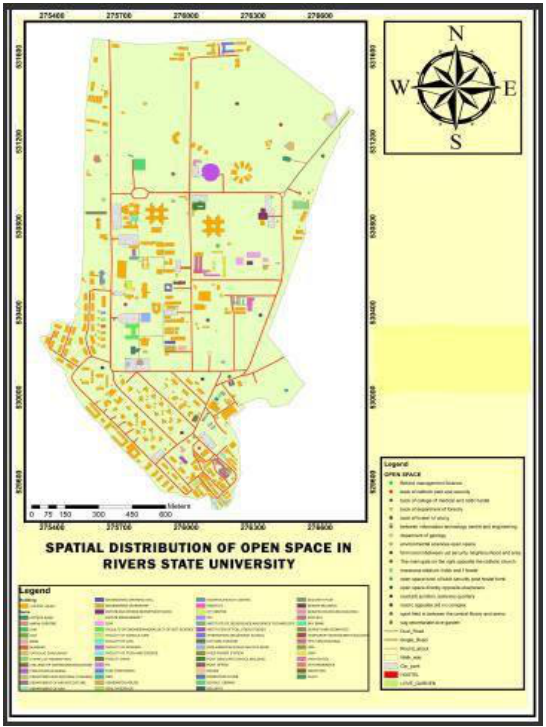
Figure 6: Spatial Distribution of Open Spaces in Rivers state